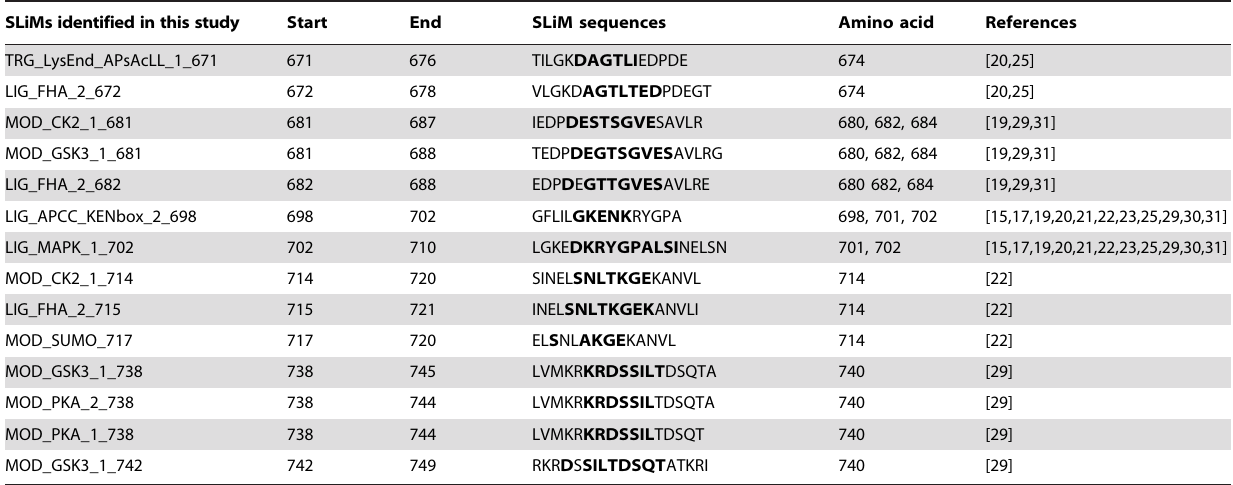
SLiMs identified in this